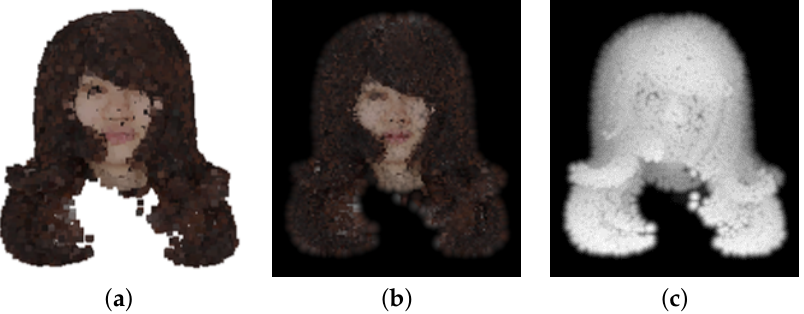
Figure 6. Point-rendered image of a point cloud; ( a ) point cloud; ( b ) color image; ( c ) depth